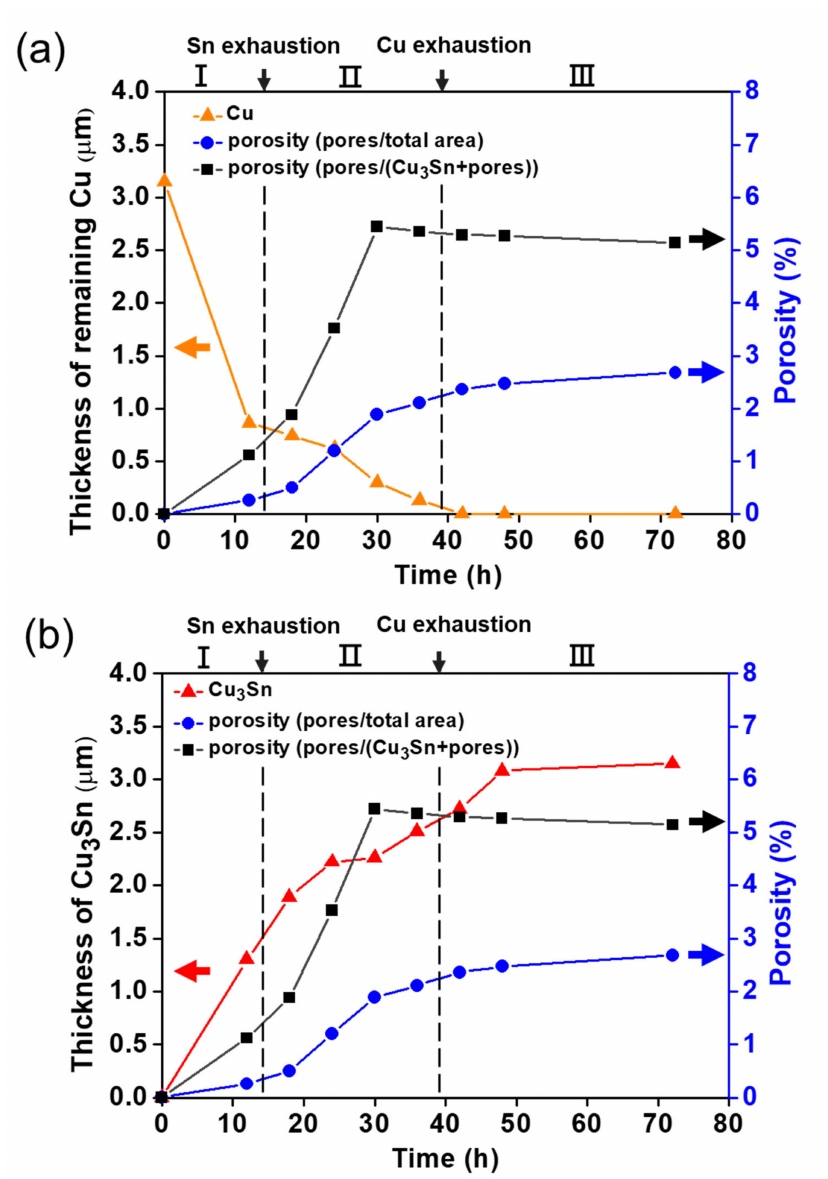
Figure 9. The correlation of porosity and ( a ) Cu thickness, ( b ) Cu 3 Sn thickness with different aging